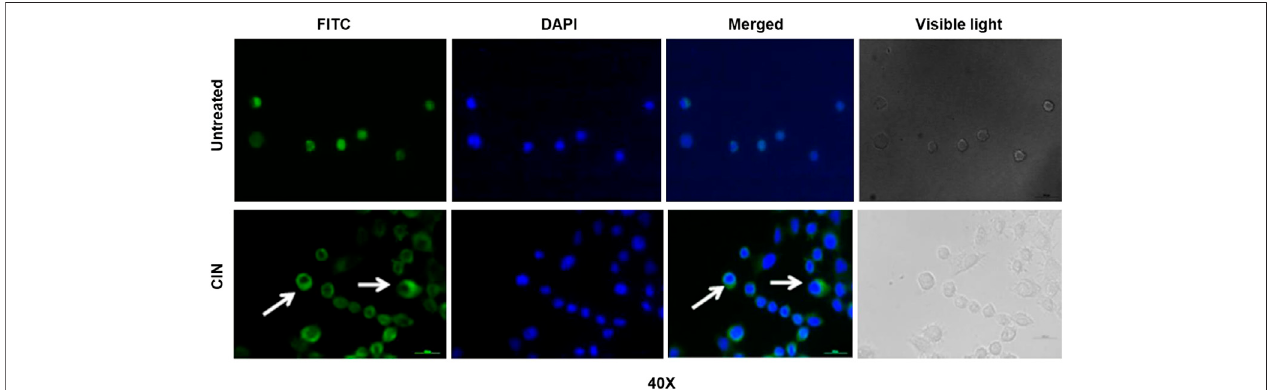
FIGURE 8 | The photomicrographs showing expression of pNF- κ B/p65 protein in SCC-4 cells. The picture shows the expression of pNF- κ B/p65 protein in untreatedandCINtreatedSCC-4cells.IntheuntreatedcellstheexpressionofpNF- κ B/p65protein(green)canbeseenincytoplasmandnucleus(blue).However,inthe treated cells the accumulation of pNF- κ B/p65 protein (green, shown by arrows) can be seen in the cytoplasm (blue: DAPI stain, green: Alexa fl our ® 488).